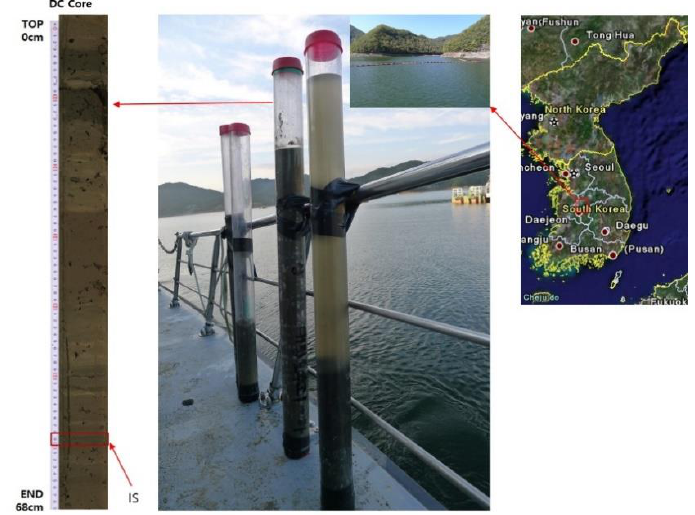
Figure 1. Sampling site and location of the Daechung Reservoir. Map shows the location of